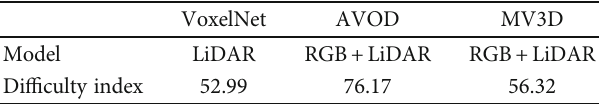
Table 2: Comparison of three-dimensional target detection